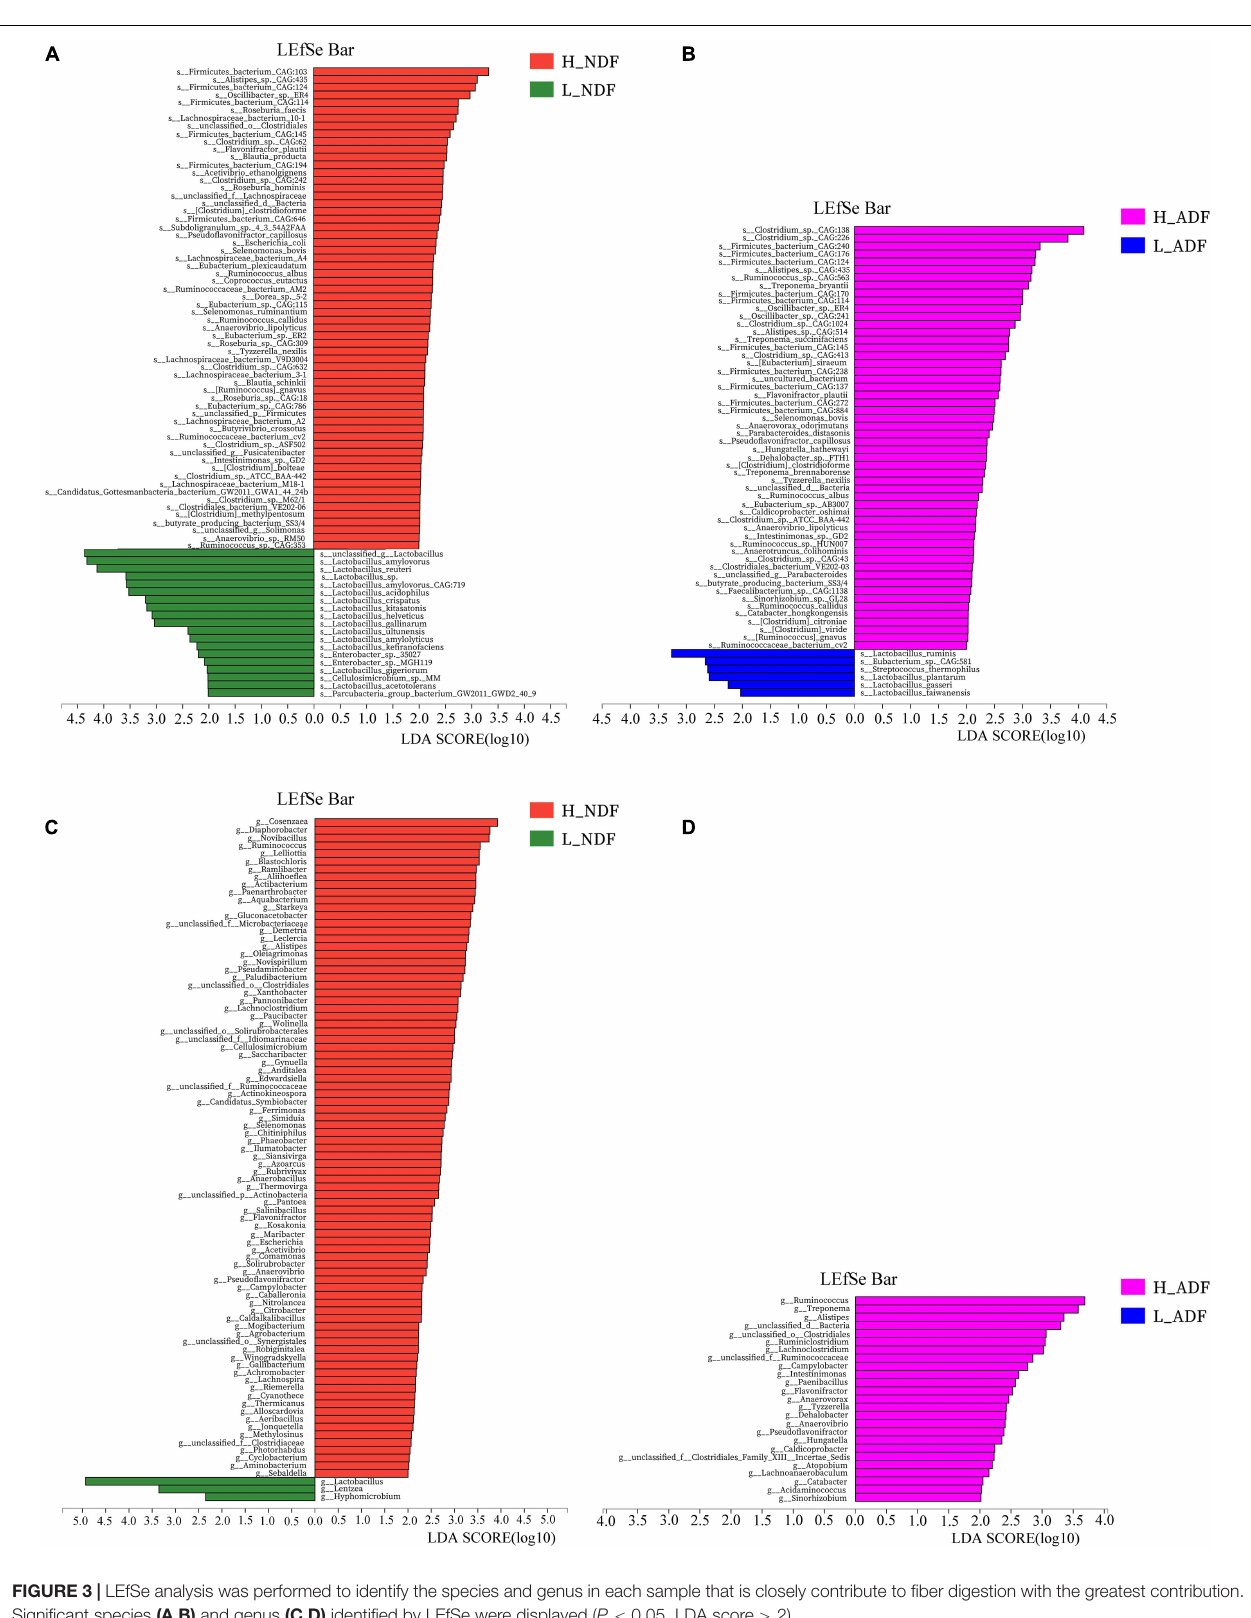
Frontiers in Microbiology |